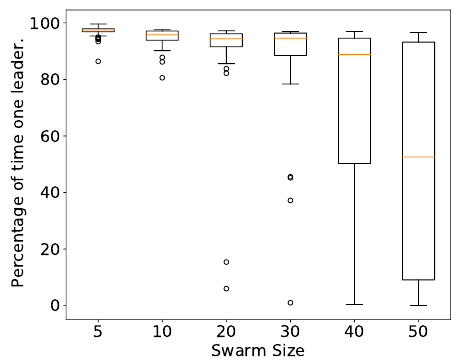
Figure 6. Assessment of the scalability capabilities of the evolved solution for the leader elec- tion task. For different swarm sizes, the figure shows the distribution of the percentage of the evaluation time that only one robot claims leadership. The sample of size 50 is represented by means of boxplots, where the orange line within the box is the median and each box en- closes samples in between the first and third quantiles, also known as the interquartile range. The whiskers extend to the farthest data points that are within 1.5 times the interquartile range. Outliers are shown as white dots.